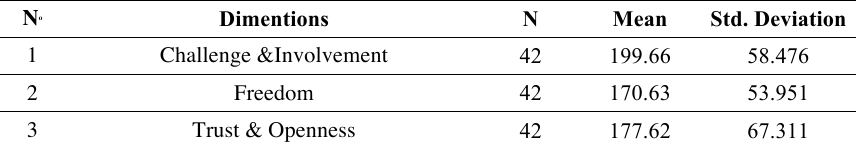
Table 2 . Means and Standard Deviations of the Technological Innovation Climate